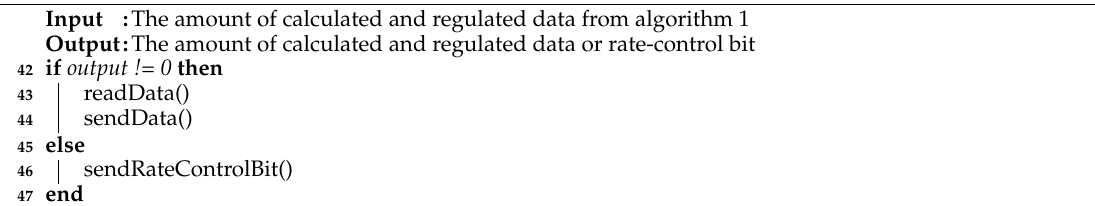
Algorithm 2: transmission_control() algorithm of EDCrammer to control caching rate for data transmission.